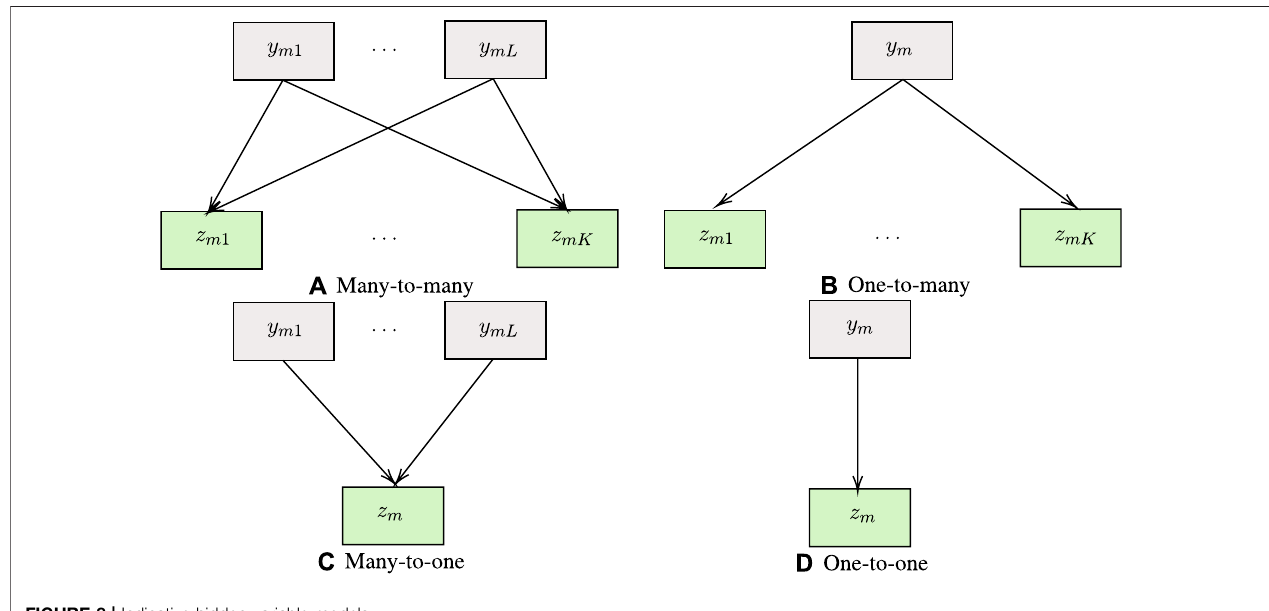
FIGURE 8 | Indicative hidden variable